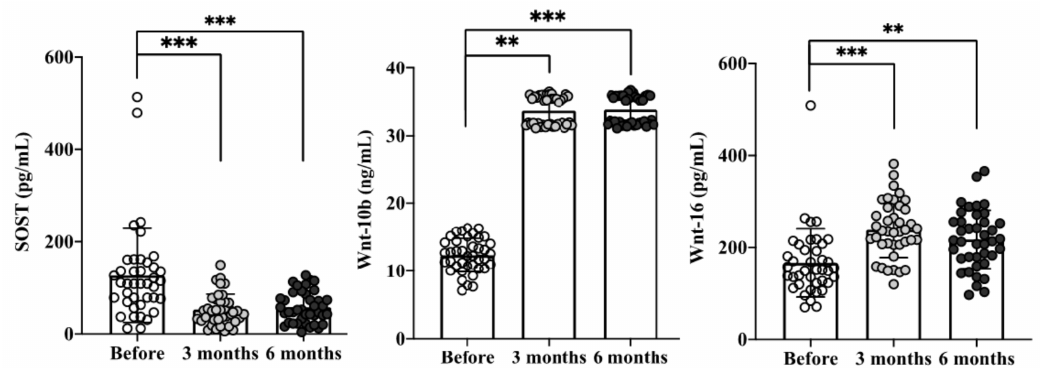
Figure 3. Cinacalcet treatment attenuates the expression of Wnt / β -catenin signaling inhibitor SOST and enhances the activity of Wnt-10b / Wnt 16 at 3rd and 6th months. Quantitative data were analyzed with a paired Student’s t -test. ** p < 0.01; and *** p < 0.001 to compare the di ff erences between the two indicated groups.